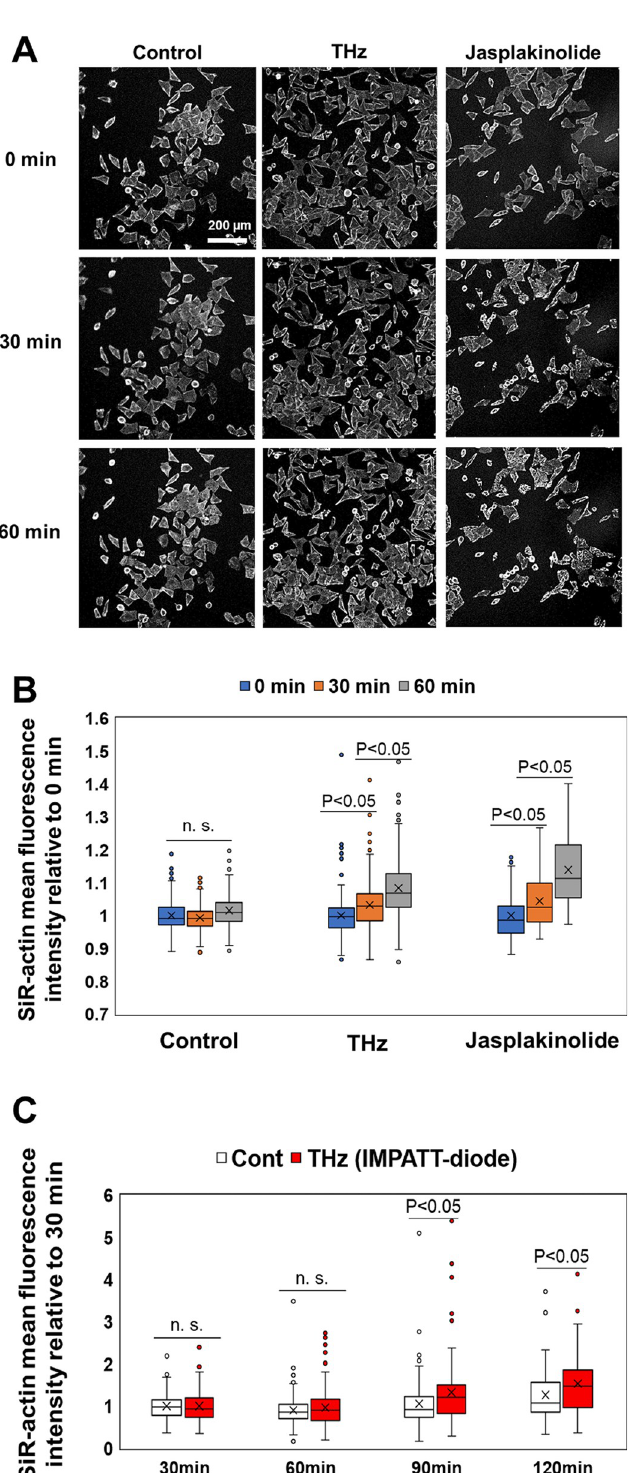
Fig 4. THz waves enhance actin polymerization in cells. (A) Fluorescence microscopy images of cells stained with SiR-actin at 0, 30, and 60 minutes. THz irradiation was started at 0 minutes and continued for 60 minutes. As a positive control, cells were treated with 10 nM jasplakinolide at 0 minutes to induce actin polymerization. The white bar shows a scale of 200 μ m. (B) Mean fluorescence intensity of SiR-actin in individual cells measured from the fluorescence microscopy images. The box plot shows the mean value relative to 0 minutes. The standard deviations of